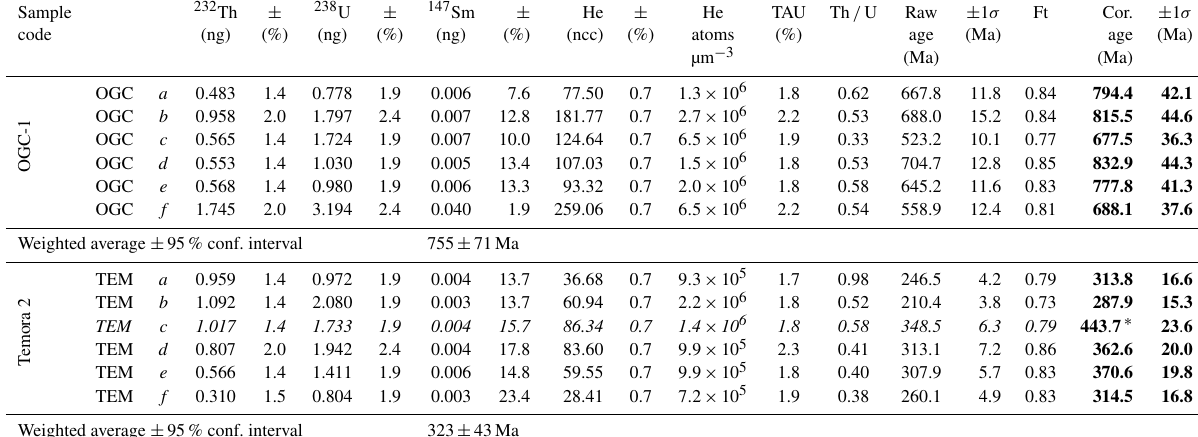
Table 3. Uranium–thorium–samarium/helium dating results. Italic is a geologically implausible result excluded from interpretation; bold is the helium retention age. Sample